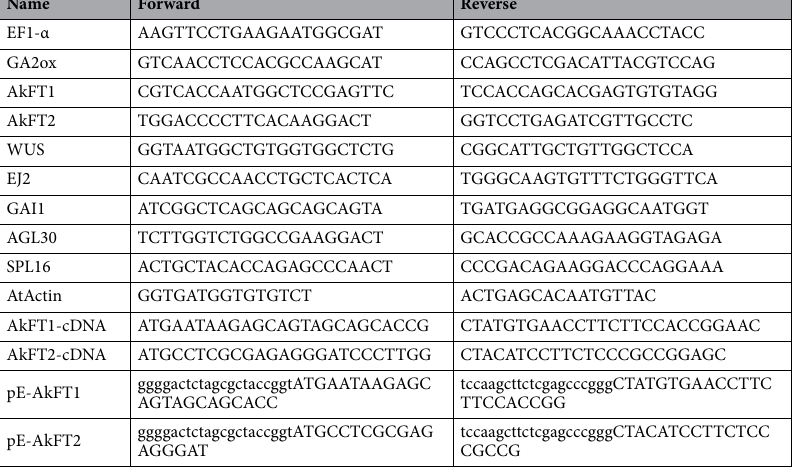
Table 1. Sequences of specific